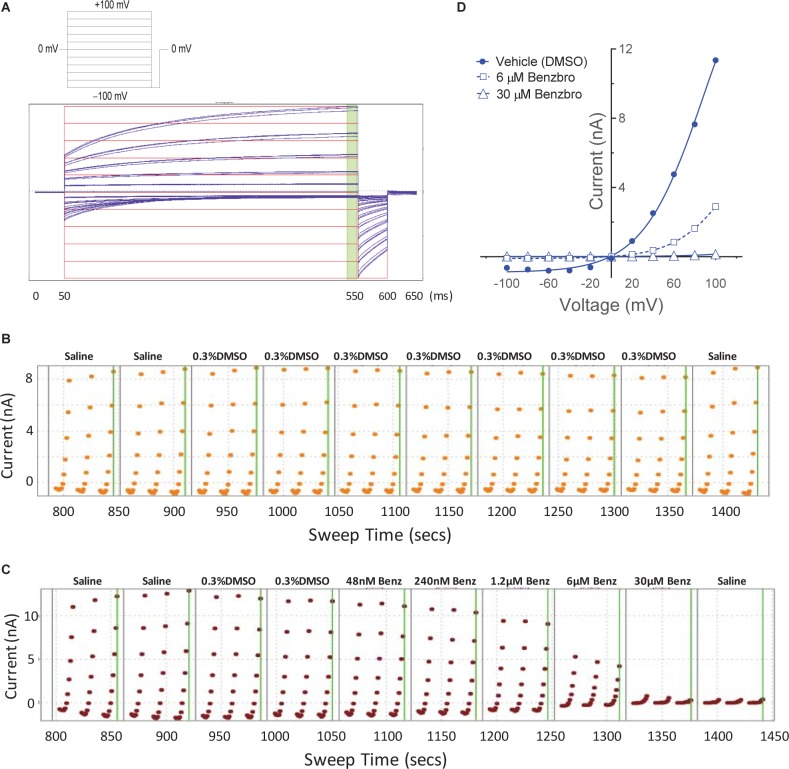
A medium-throughput, optimized planar patch clamp electrophysiology assay for stable recordings and routine measures of compound activity in blocking TMEM16A. (A) Representative whole-cell currents of a HEK293 cell stably transfected with TMEM16A (acd) using an intracellular solution containing 170 nM free calcium. The standard QPatch voltage protocol had cells clamped from a holding potential of 0 mV (50 ms) to voltages between –100 and +100 mV in 20 mV steps (500 ms) followed by a step to –100 mV for 50 ms. There were 1.2 s between sweeps, 20 s between protocols, and three protocols run per sample addition which allowed at least 60 s incubation time following each vehicle or compound addition. (B) The TMEM16A currents were stable for at least 10 min and after repeat additions of the vehicle control (0.3% DMSO) in the optimized assay as shown in the representative recording, where the dots reflect the measured current from 540 to 550 ms after each 20 mV step from –100 to +100 mV, and three IV protocols are shown for each sample addition. Benzbromarone caused a dose-dependent inhibition of TMEM16A, which exhibited the typical outward rectification as shown in the representative instrument recording in (C) and the IV curves plotted in (D) of data from a separate recording showing currents measured at each voltage step during the third IV protocol.